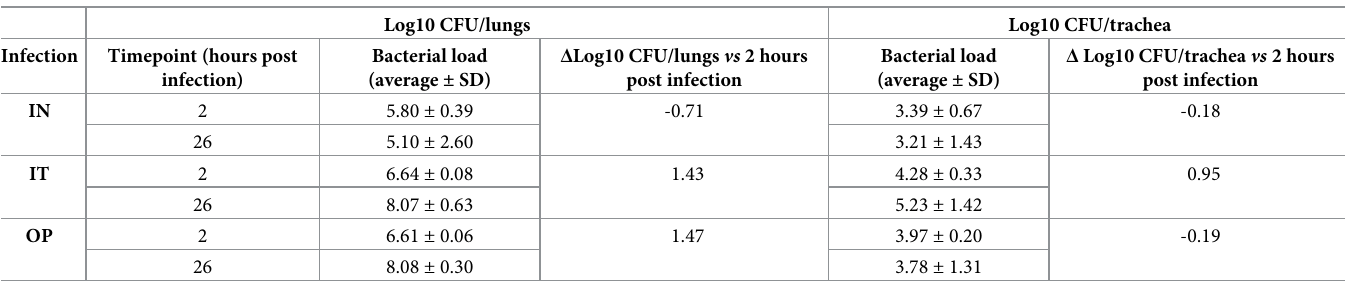
Table 2. Bacterial load in tissues of A . baumannii ACC001 infected mice.